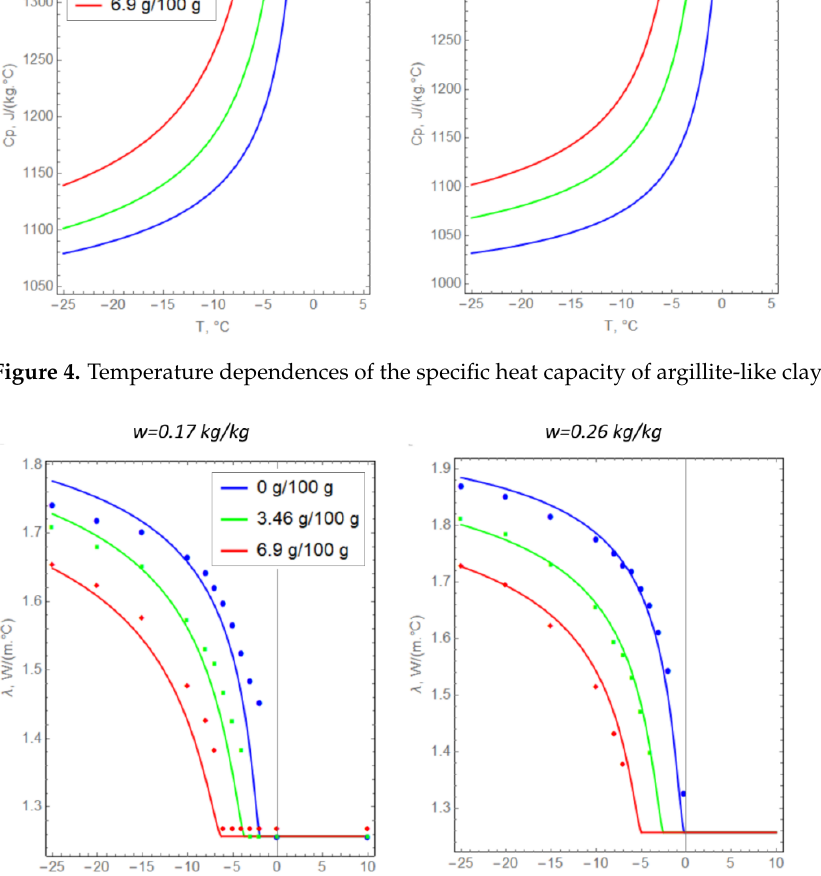
Figure 5. Temperature dependences of the thermal conductivity of argillite-like clay: solid lines